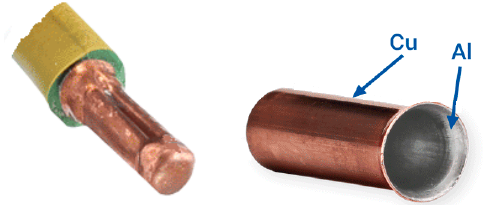
Figure 2. Example application of a bimetal clamp for an aluminum conductor and a bimetallic cup used for electric connectors. Based on [2] .